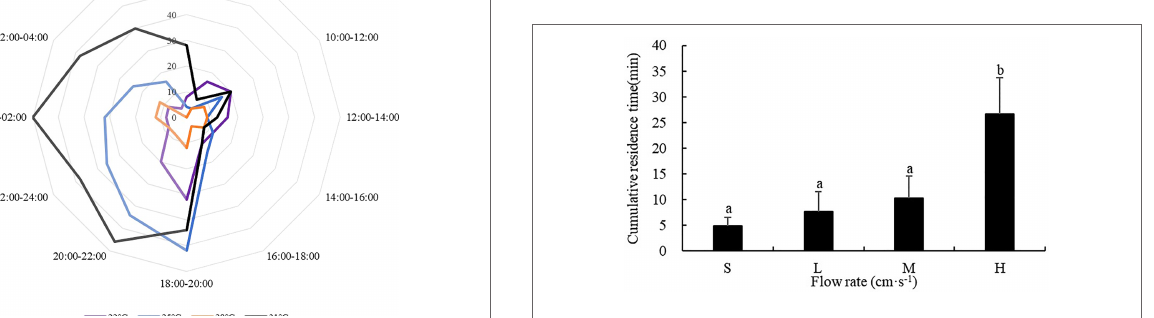
FIGURE 8 | Cumulative residence time of S. monotuberculatus at four different flow rates. S, L, M, and H represent the four flow rates: 0 cm/s, 4.7 ± 1.2 cm/s, 10.5 ± 1.7 cm/s, and 20.8 ± 3.4 cm/s